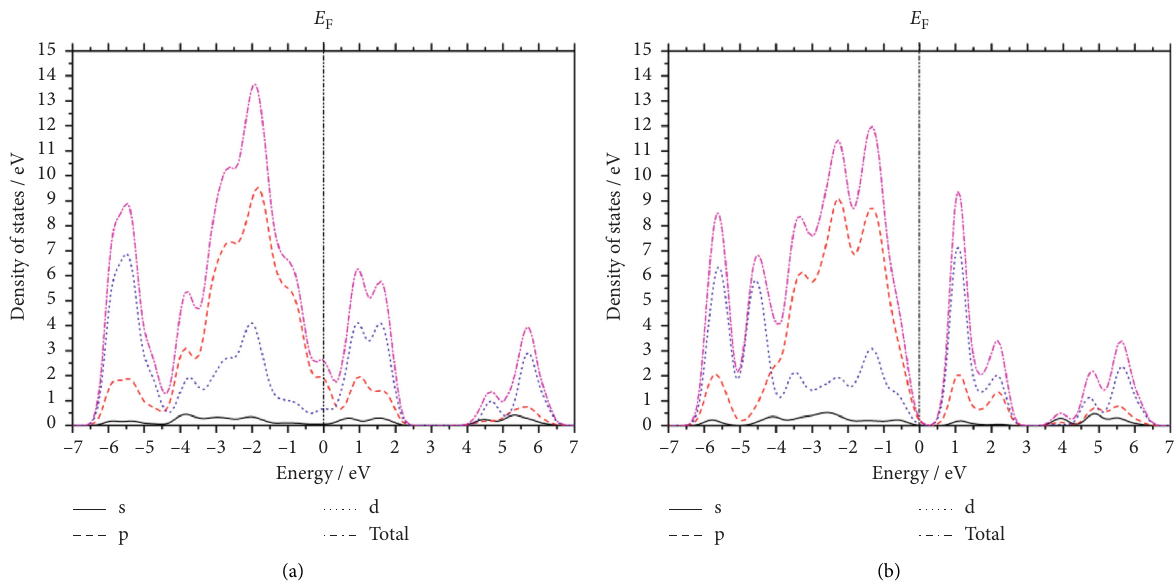
Figure 7: Detailed electron density of states of sandwiched Ca